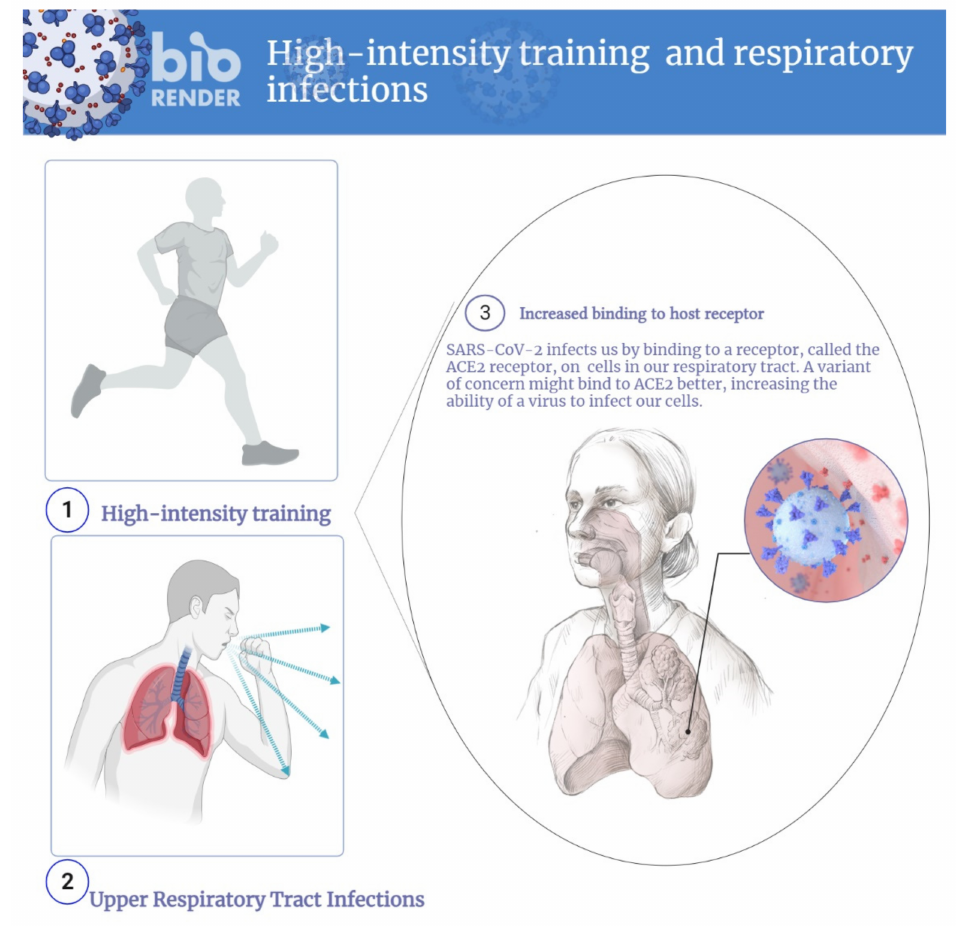
Figure 1. High-intensity exercise and upper respiratory tract